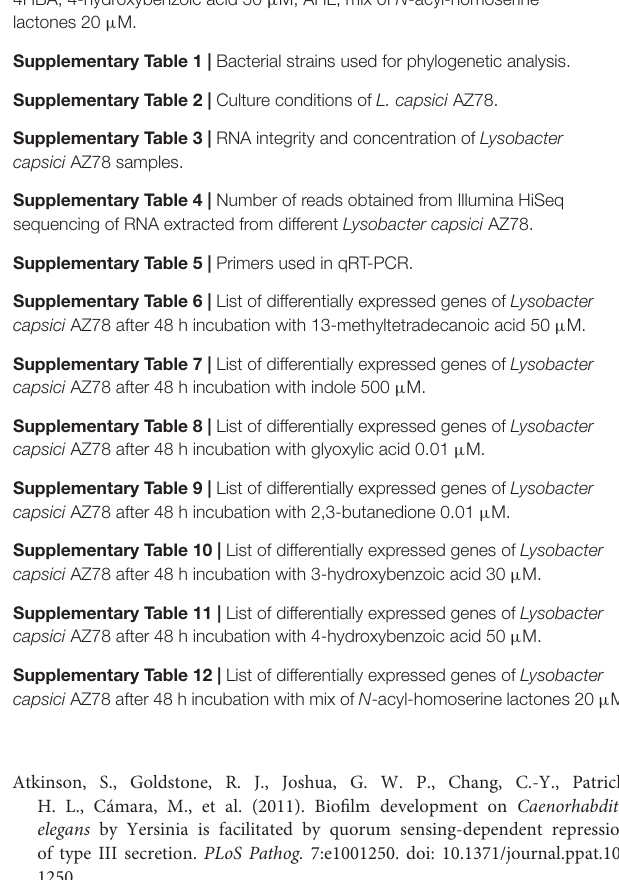
Supplementary Table 1 | Bacterial strains used for phylogenetic analysis. Supplementary Table 2 | Culture conditions of L. capsici AZ78.